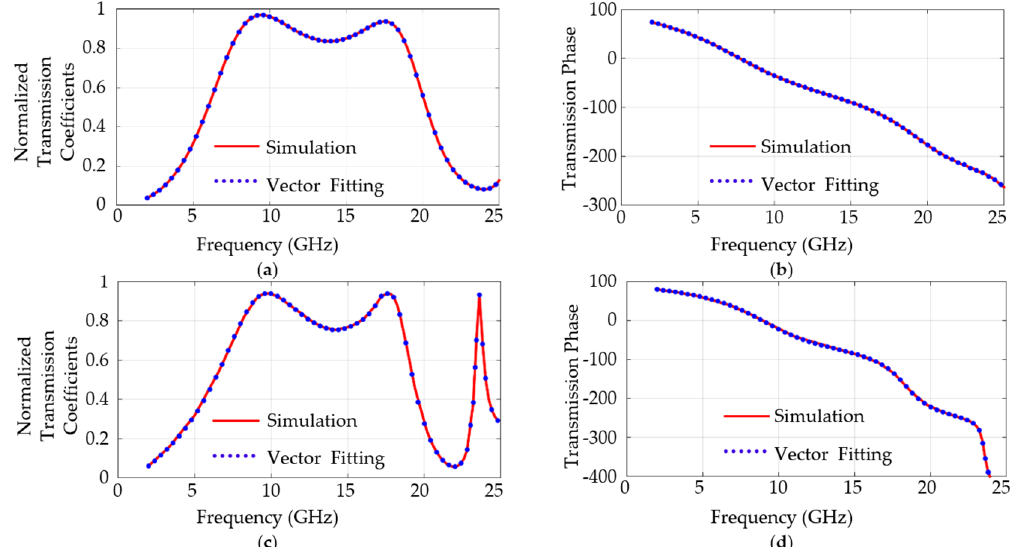
Figure 4. The transmission coefficients and transmission coefficients phase comparisons of simulation and vector fitting with different incident TE wave: ( a ) Vertical incident normalized transmission coefficients; ( b ) vertical incident transmission coefficients phase; ( c ) 50° incident normalized transmission coefficients and ( d ) 50° incident transmission coefficients phase.